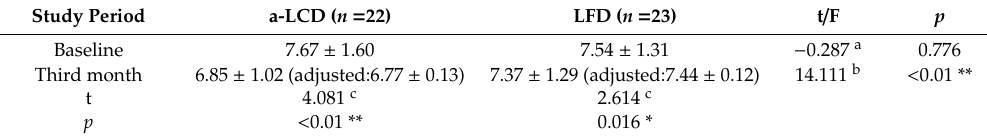
Table 3. Comparison of glycated hemoglobin (%) between the two groups.